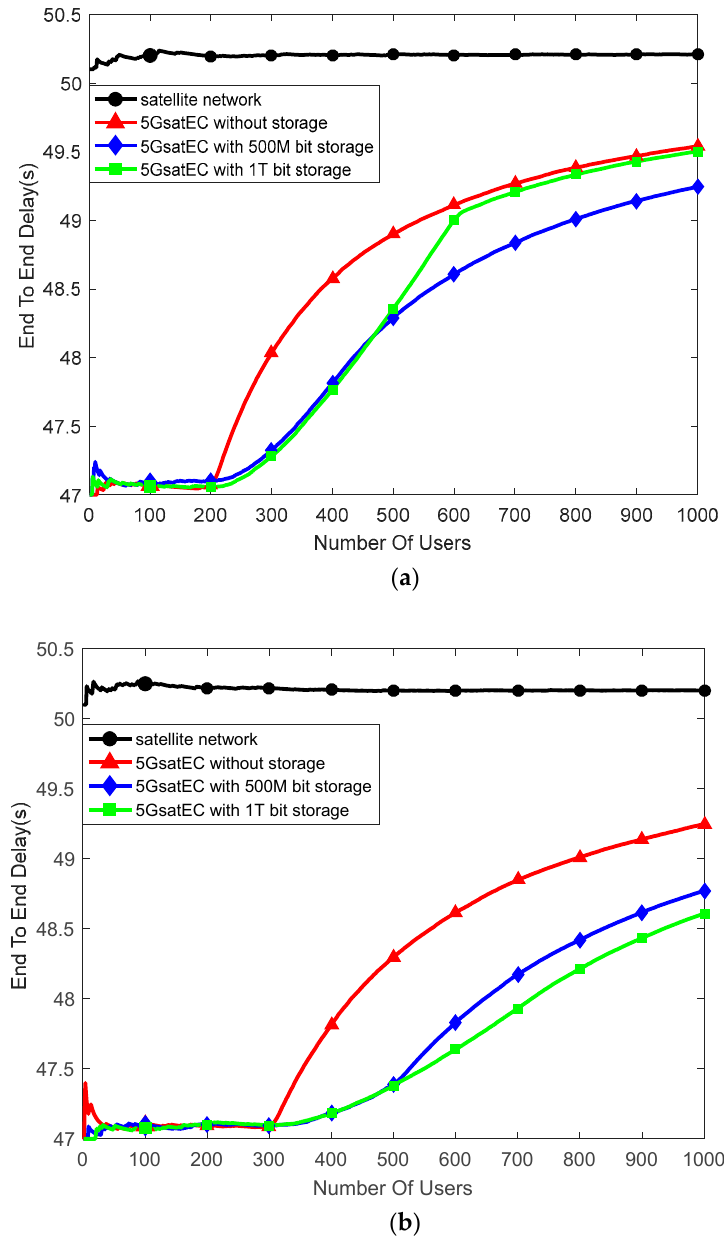
Figure 9. Delay between the satellite network and 5GsatEC. ( a ) Two computing cores with different storage capacities and ( b ) three computing cores with different storage capacities.